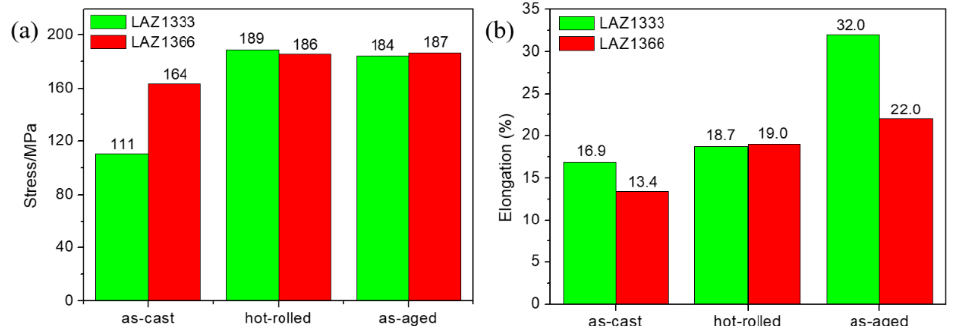
Figure 14. Histograms of mechanical properties of the LAZ13 xy ( x = 3, 6 wt%, y = 3, 6 wt%) alloys in different states: ( a ) ultimate tensile strength (UTS), ( b ) fracture elongation (FE).